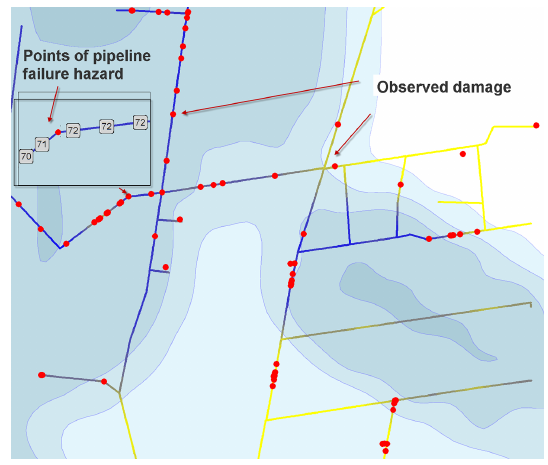
Figure 5. Evaluation of failure hazard of a pipeline performed with a fuzzy model (yellow dotted line: endangered part of the pipeline, red dot: observed damage, line with the blue intensive color-predicted high risk of pipeline